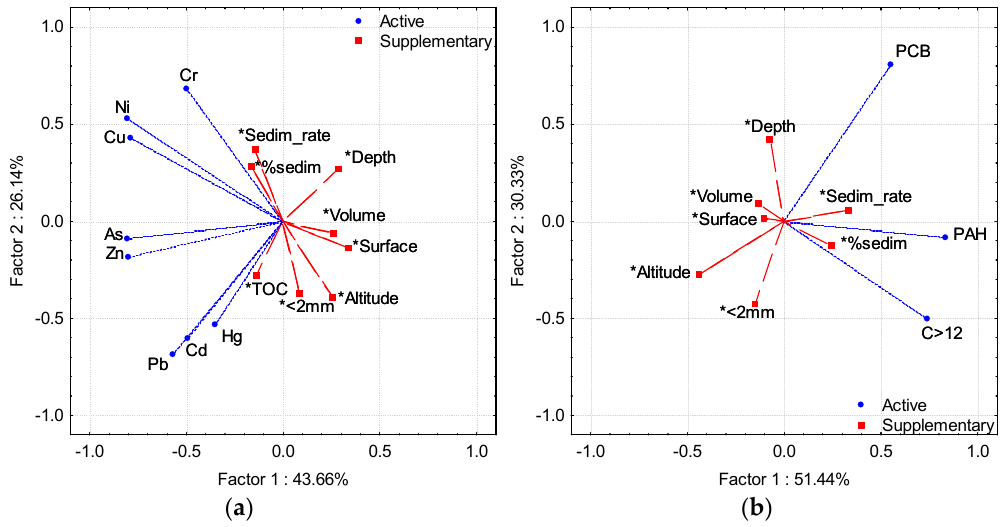
Figure 3. Plots of Principal Component Analysis according to axis 1 and 2 of: ( a ) trace elements; and ( b ) organics. Active and supplementary variables are represented. Sedim_rate = sedimentation rate; %sedim = sedimentation level.